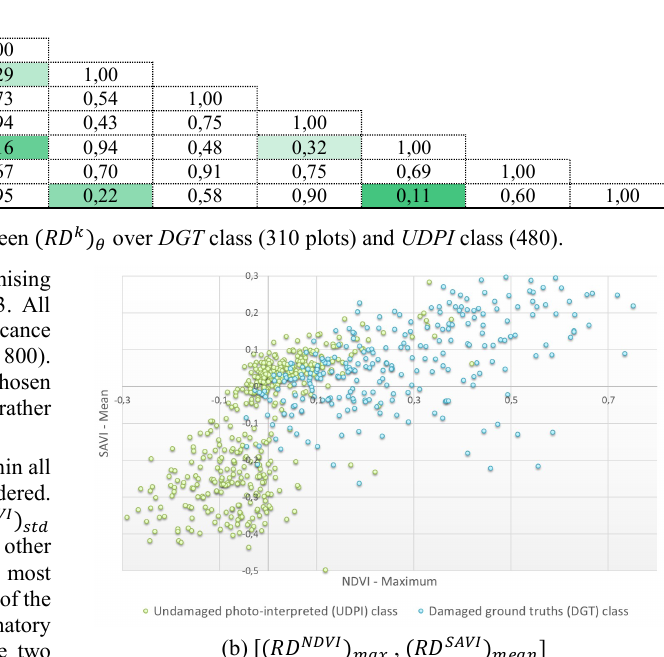
(b) [(𝑅𝐷 (cid:3015)(cid:3005)(cid:3023)(cid:3010) ) (cid:3040)(cid:3028)(cid:3051) , (𝑅𝐷 (cid:3020)(cid:3002)(cid:3023)(cid:3010) ) (cid:3040)(cid:3032)(cid:3028)(cid:3041) ] Figure 7 . Scatter plots of training sample by class type. NDWI (lines 3 and 4) unsurprisingly leads to overestimation of damaged lands with smaller producer accuracy on UDPI * plots. scores across the two classes are obtained with the combined